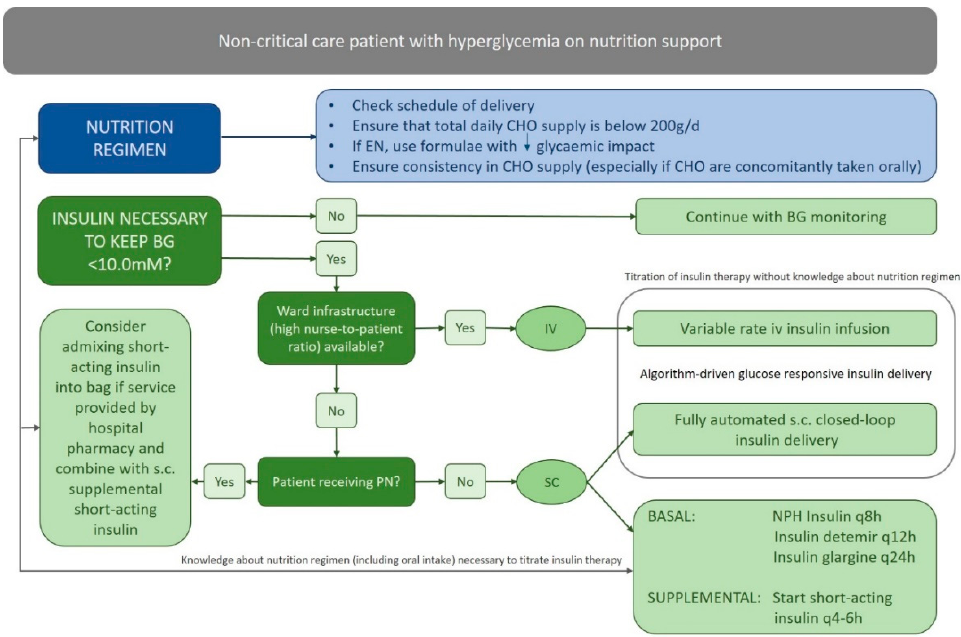
Figure 4. Approach to the management of hyperglycemia in patients receiving enteral or parenteral nutrition. CHO = carbohydrates, EN = enteral nutrition, BG = blood glucose, IV = intravenous, PN = parenteral nutrition, SC = subcutaneous, and q8h = dosing every 8 h.